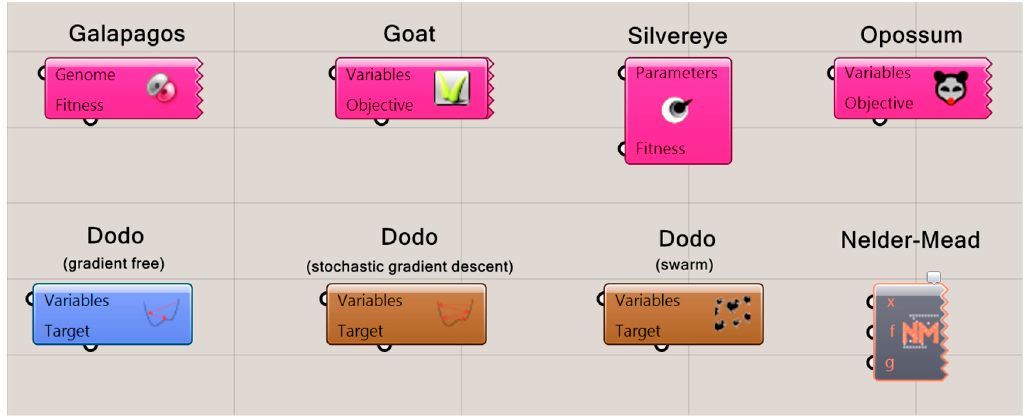
Figure 2. Existing single-objective optimization plug-ins in grasshopper (GH).